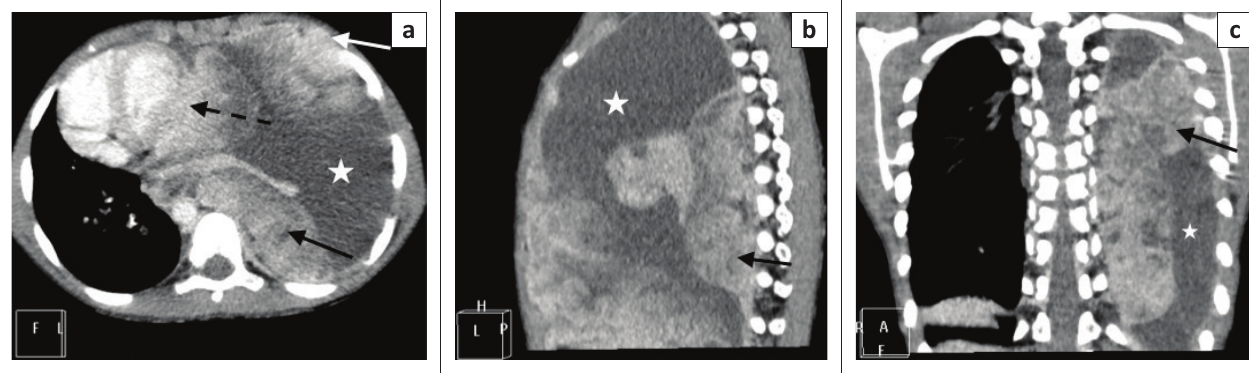
FIGURE 2: (a–c) Axial, sagittal and coronal contrast-enhanced computed tomography images demonstrate left pleural-based masses which enhance heterogeneously (solid black arrows) with patchy hypodense regions suggestive of necrosis. There is an associated large complex left pleural effusion (white star), atelectasis of the left lung and mediastinal shift to the right. There were no associated intra-tumoural calcifications. Figure 2A – Note the extra-thoracic extension of the mass anteriorly via the intercostal spaces (white arrow) and another pleural-based mass that is inseparable from the pleural pericardial reflection (broken black arrow).